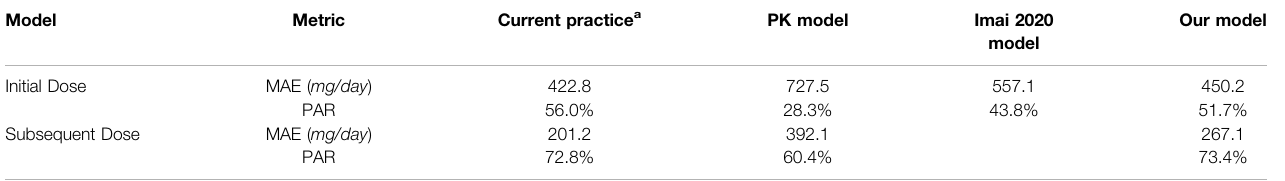
TABLE 4 | Model performance of vancomycin injection (Test